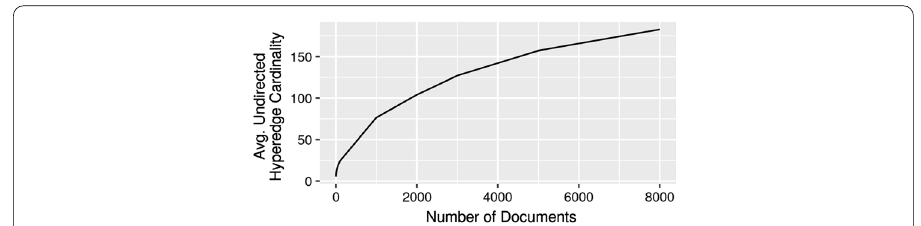
Fig. 14 Average hyperedge cardinality over time for the synonyms model